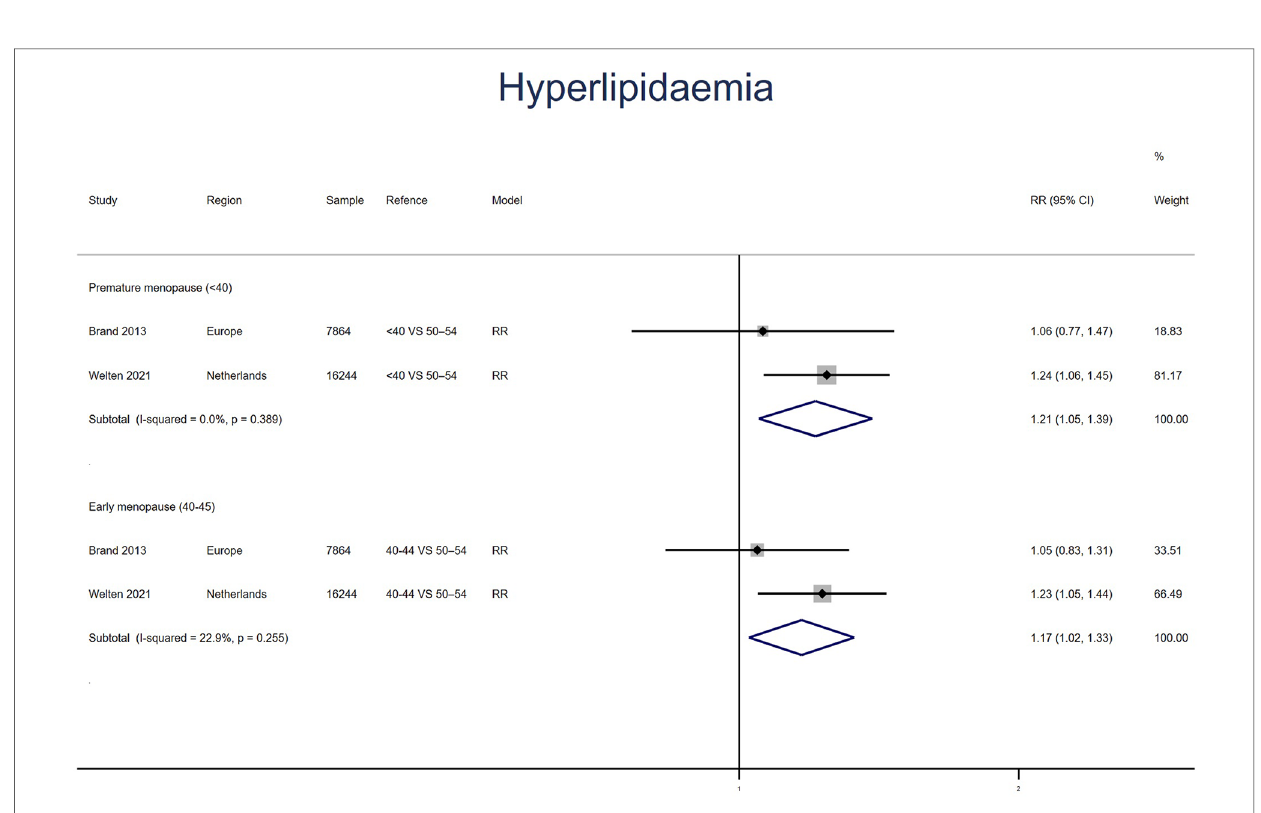
FIGURE 4 Forest plot presents the association between PM or EM and the risk of hyperlipidaemia in cohort